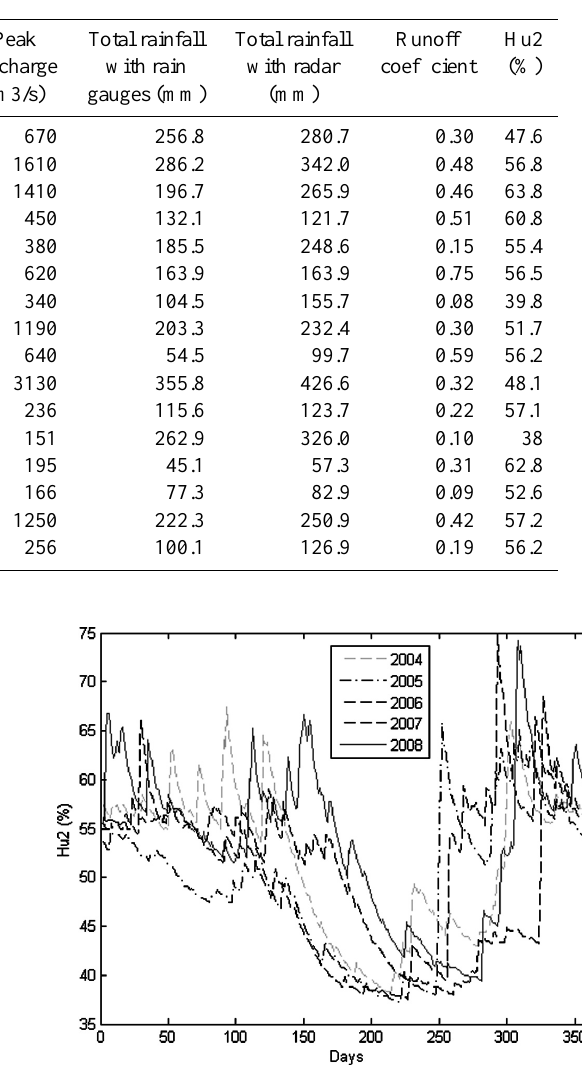
Table 1. Characteristics of the selected flood events.